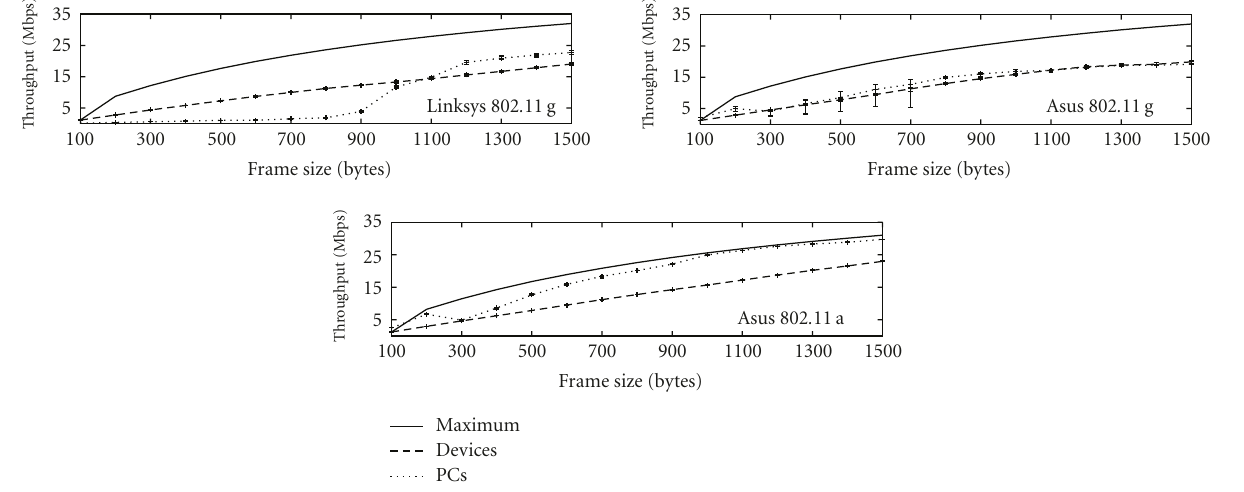
Figure 3: Impact of using the wireless devices to generate tra ffi c.